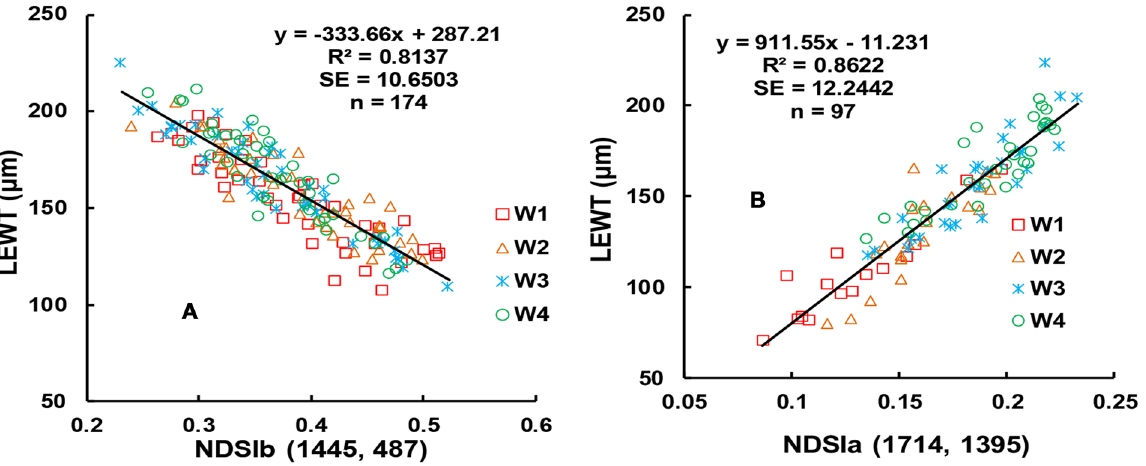
Figure 6. Contour map of the linear relationship with top 15% R 2 between NDSI and LEWT before (A) and after (B) anthesis, and the common area between A and B (C).